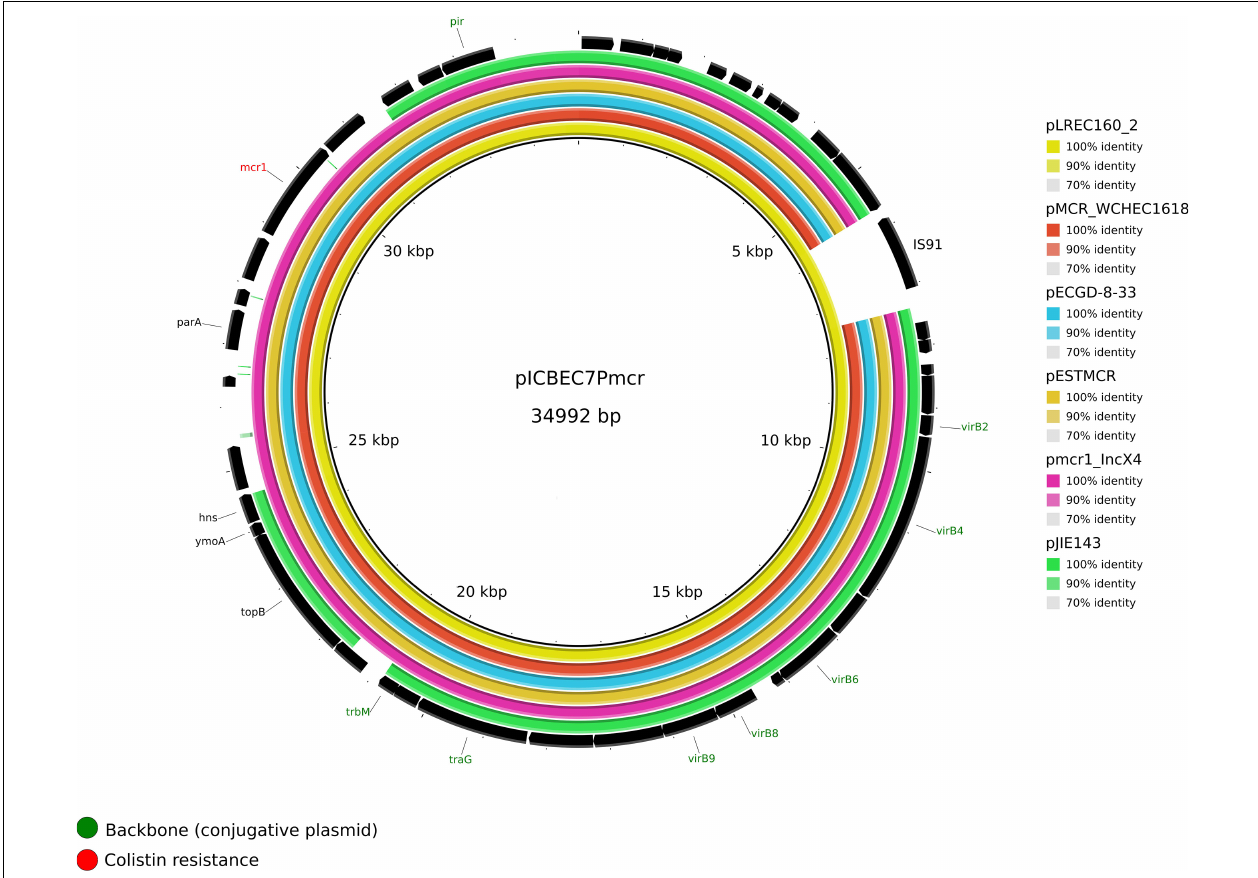
FIGURE 2 | Structural comparison between mcr -1 plasmids and IncX4 references. The alignment includes five references and the one IncX4 mcr -1–bearing plasmid found in our study. The plasmid pICBEC7 mcr (IncX4) was used as a reference to match with the other plasmids with [pMCR_WCHEC1618, pECGD-8-33, pESTMCR, and pmcr1_IncX4] and without the mcr -1 gene [pIJE143]. The outer circle with black arrows denotes the annotation of reference sequence pICBEC7mcr. The image was generated using BRIG (default parameters with 90/70 as upper/lower